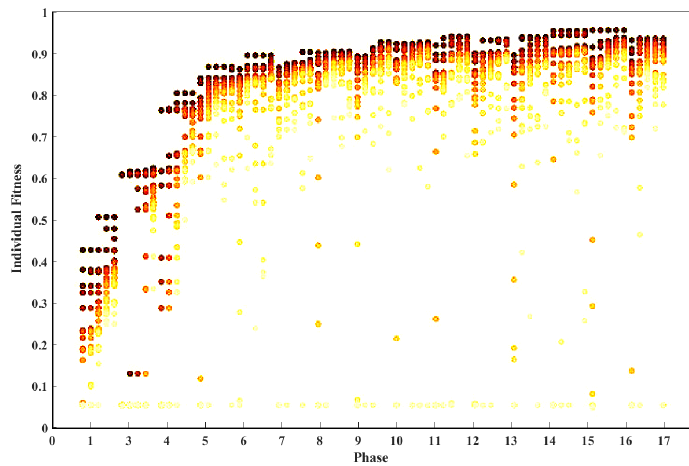
Figure 9. Fitness functions of the 20 fittest solutions returned after each performed phase. For illustration purposes, 17 phases are reported to show the validity of the proposed stopping criterion. Indeed, note that the accuracy slightly decreases after phase 15, i.e., layers added at phases 15, 16 and 17 are not needed. Table 4. The details of layers used in the designed